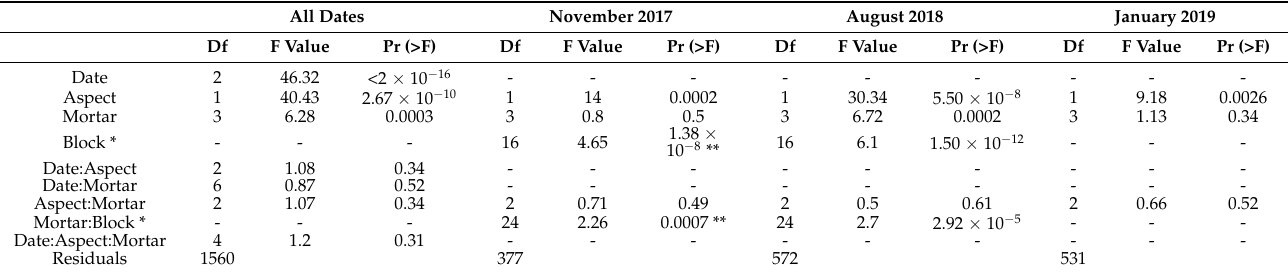
Table 4. Results of factorial analysis of variance (ANOVA) tests on surface hardness data, evaluating effect of individual variables and interactions of variables on distribution of surface hardness measurements. Main effects (p < 0.001) in bold, less significant effects (p < 0.01) in